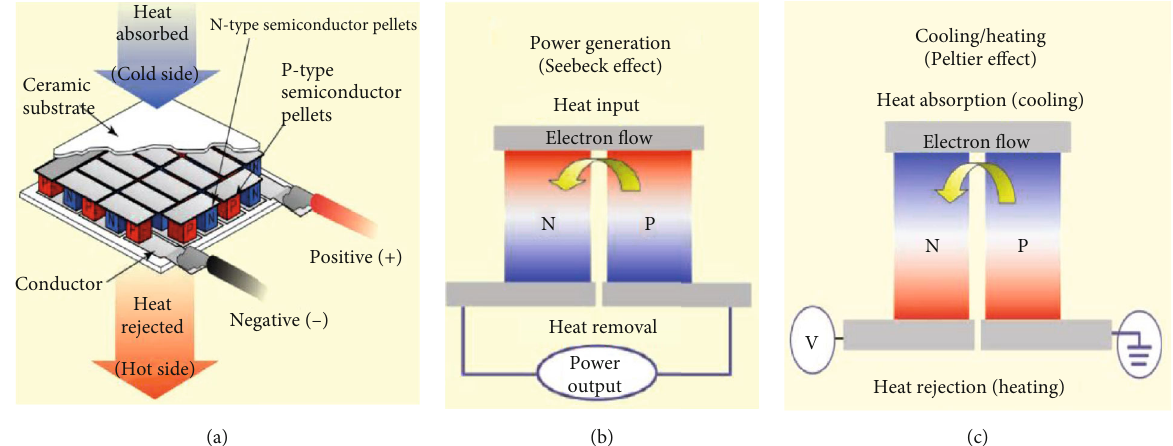
Figure 1: Thermoelectric device as (a) construct, (b) TEG, and (c) TEC (adapted from [4]).